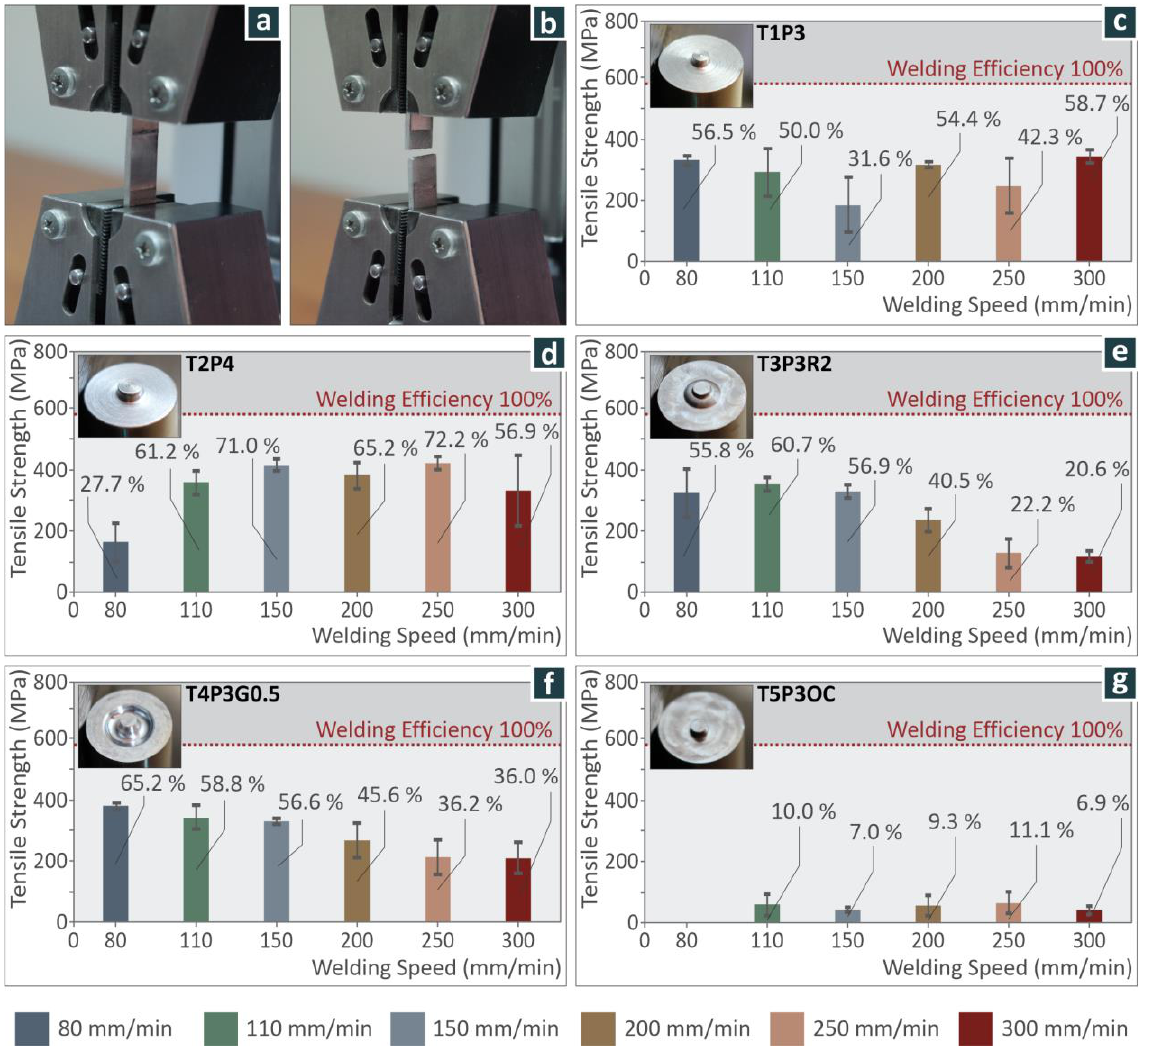
Figure 5. ( a ) Tensile test experimental setup, ( b ) welded specimen after it failed in the tensile test, and average tensile strength and deviation of welds produced with the tool ( c ) T1P3, ( d ) T2P4, ( e ) T3P3R2, ( f ) T4P3G0.5, and ( g ) T5P3OC. The welding efficiency is outlined in the graphs.